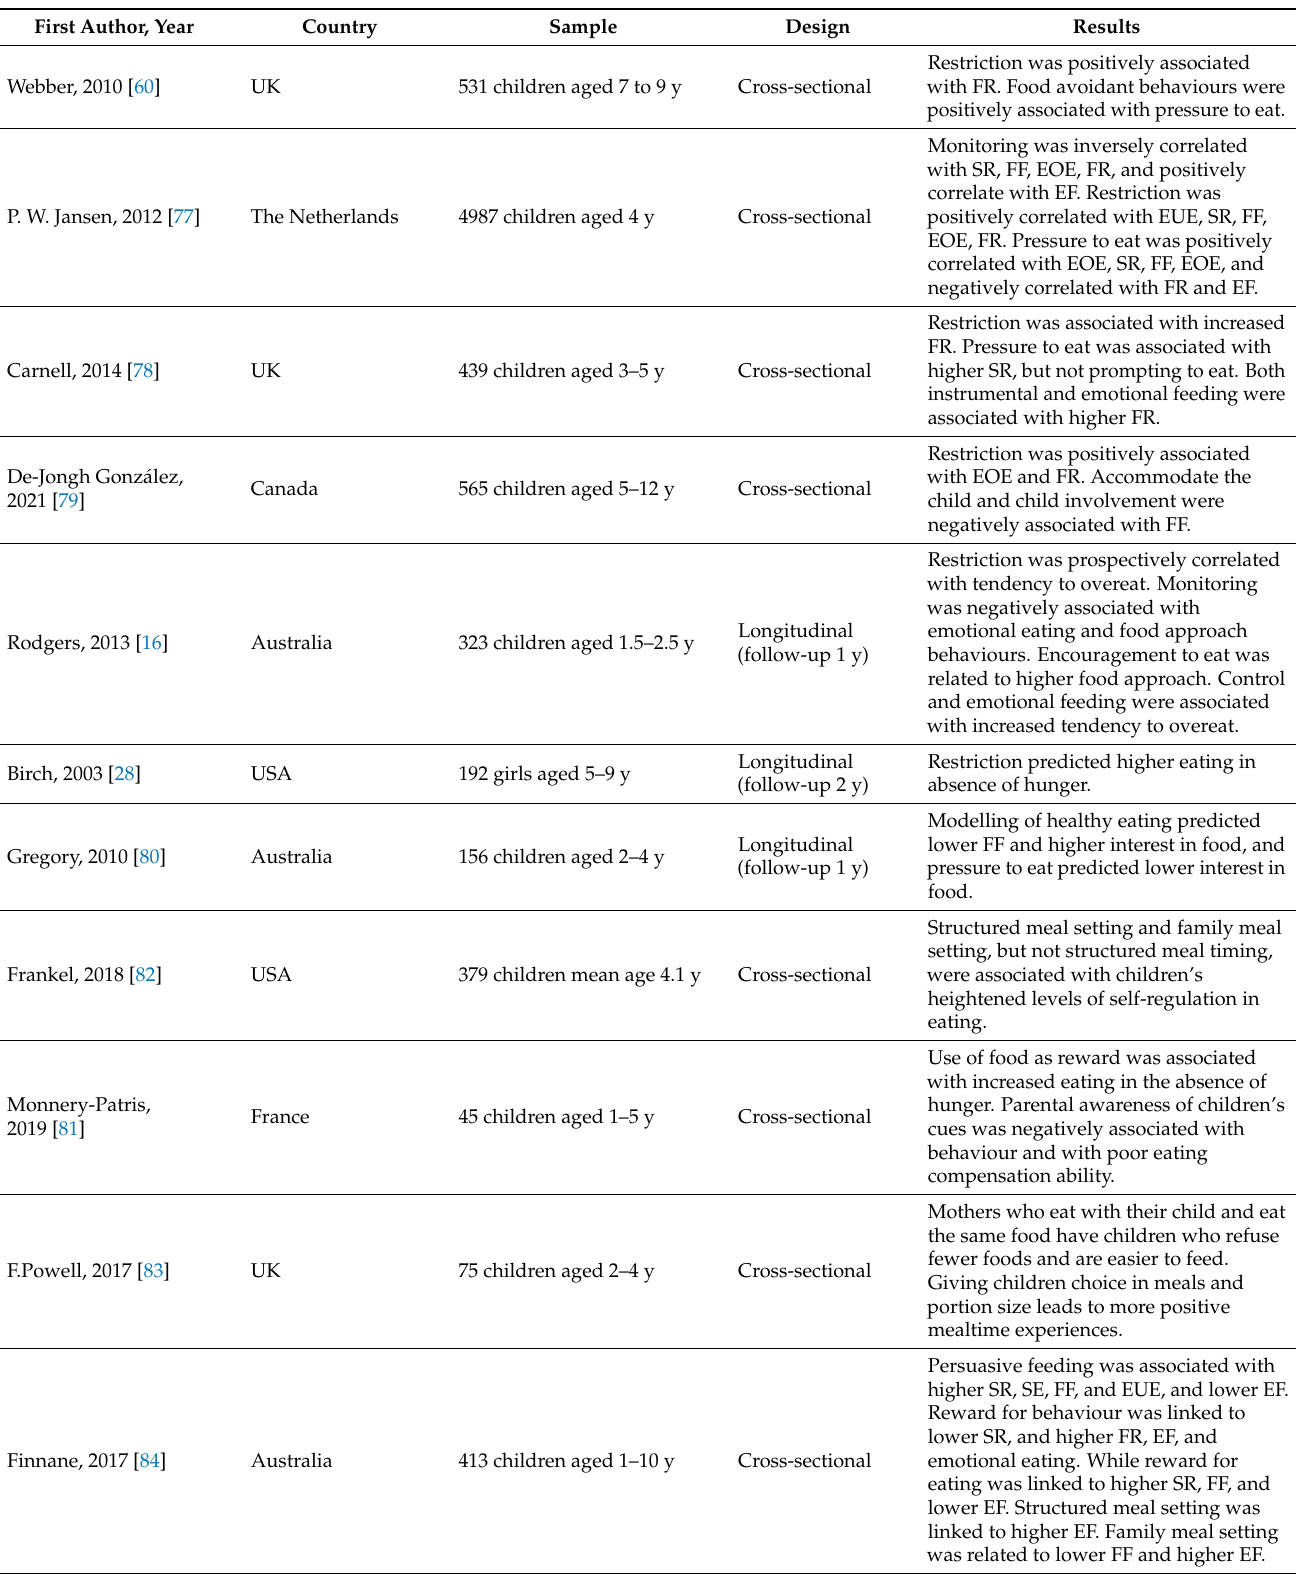
Table 2. Studies on the association between parental feeding practices and children’s eating